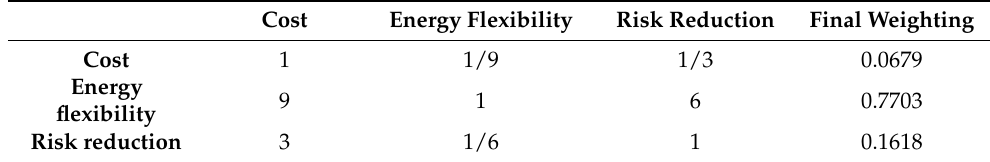
Table 4. Decision matrix for the AHP.